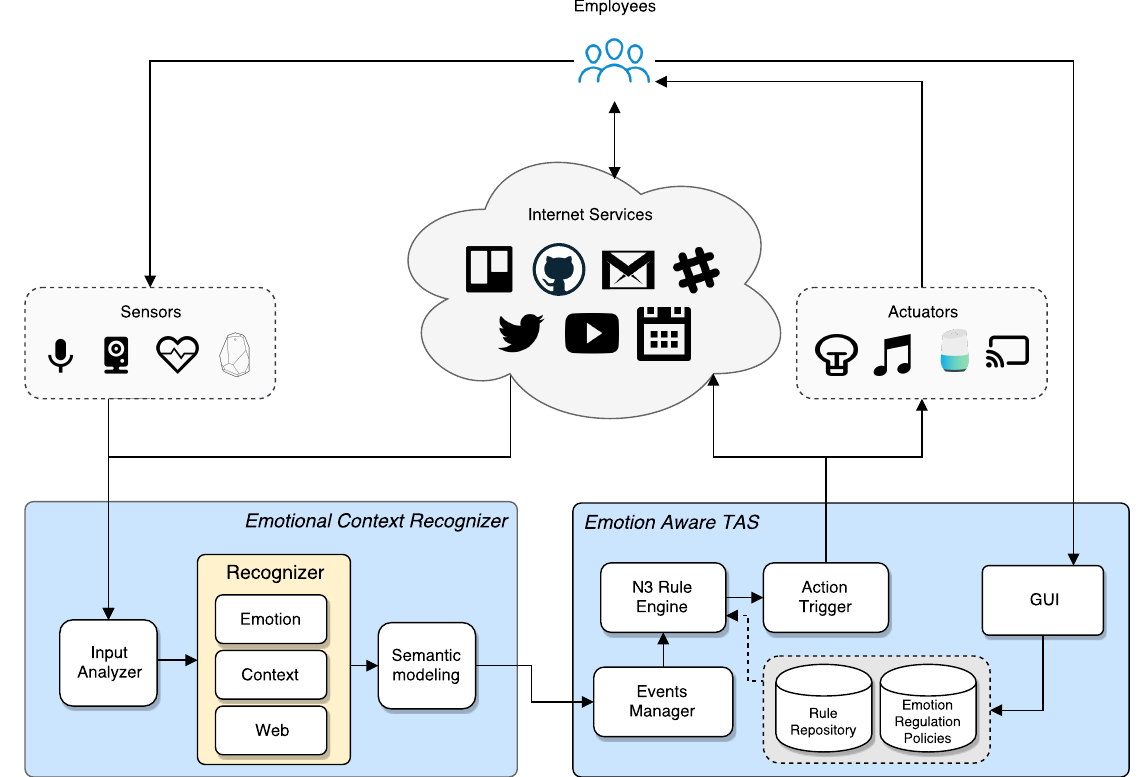
Figure 2. Emotion Aware Automation Platform